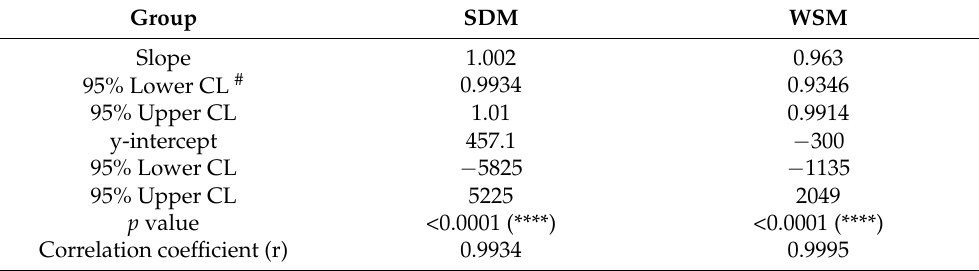
Table 3. Summary of Deming regression of Tetrahymena cell density using SDM and WSM at several different cell